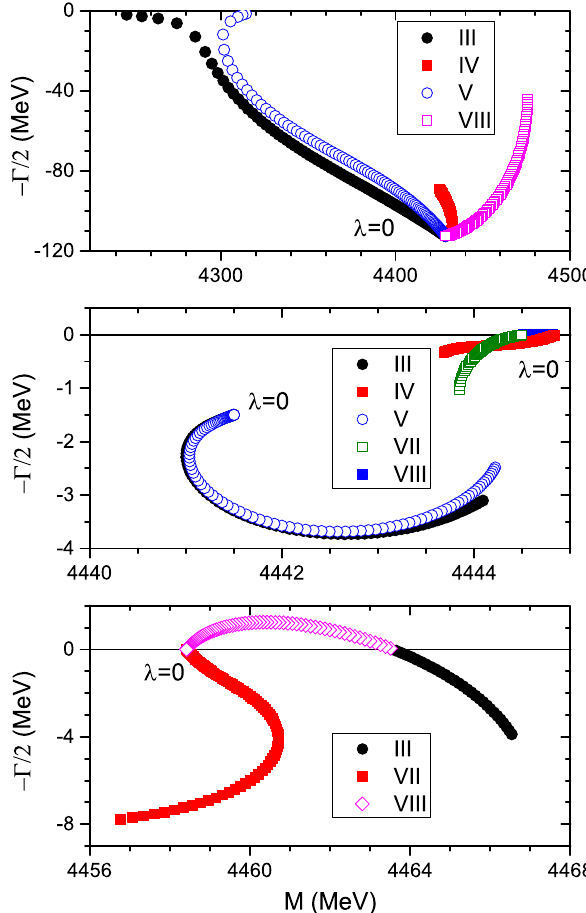
Fig. 4 The trajectories of the poles of Fit 2. λ is varied from 1 to 0, and the step of (cid:16)λ is